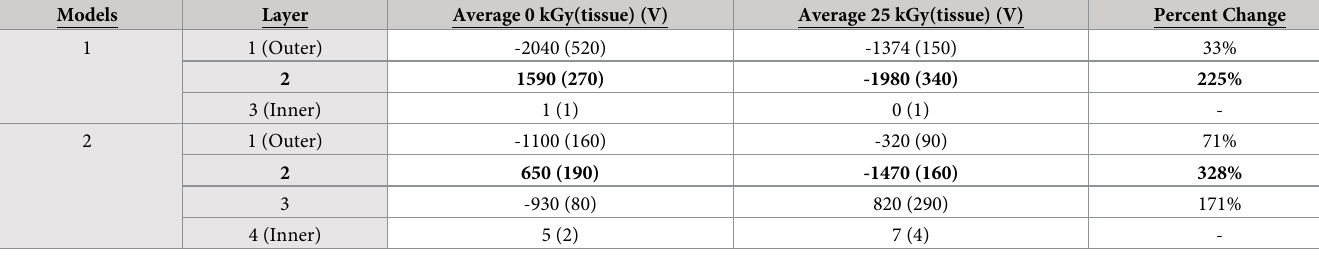
Standard deviation given in